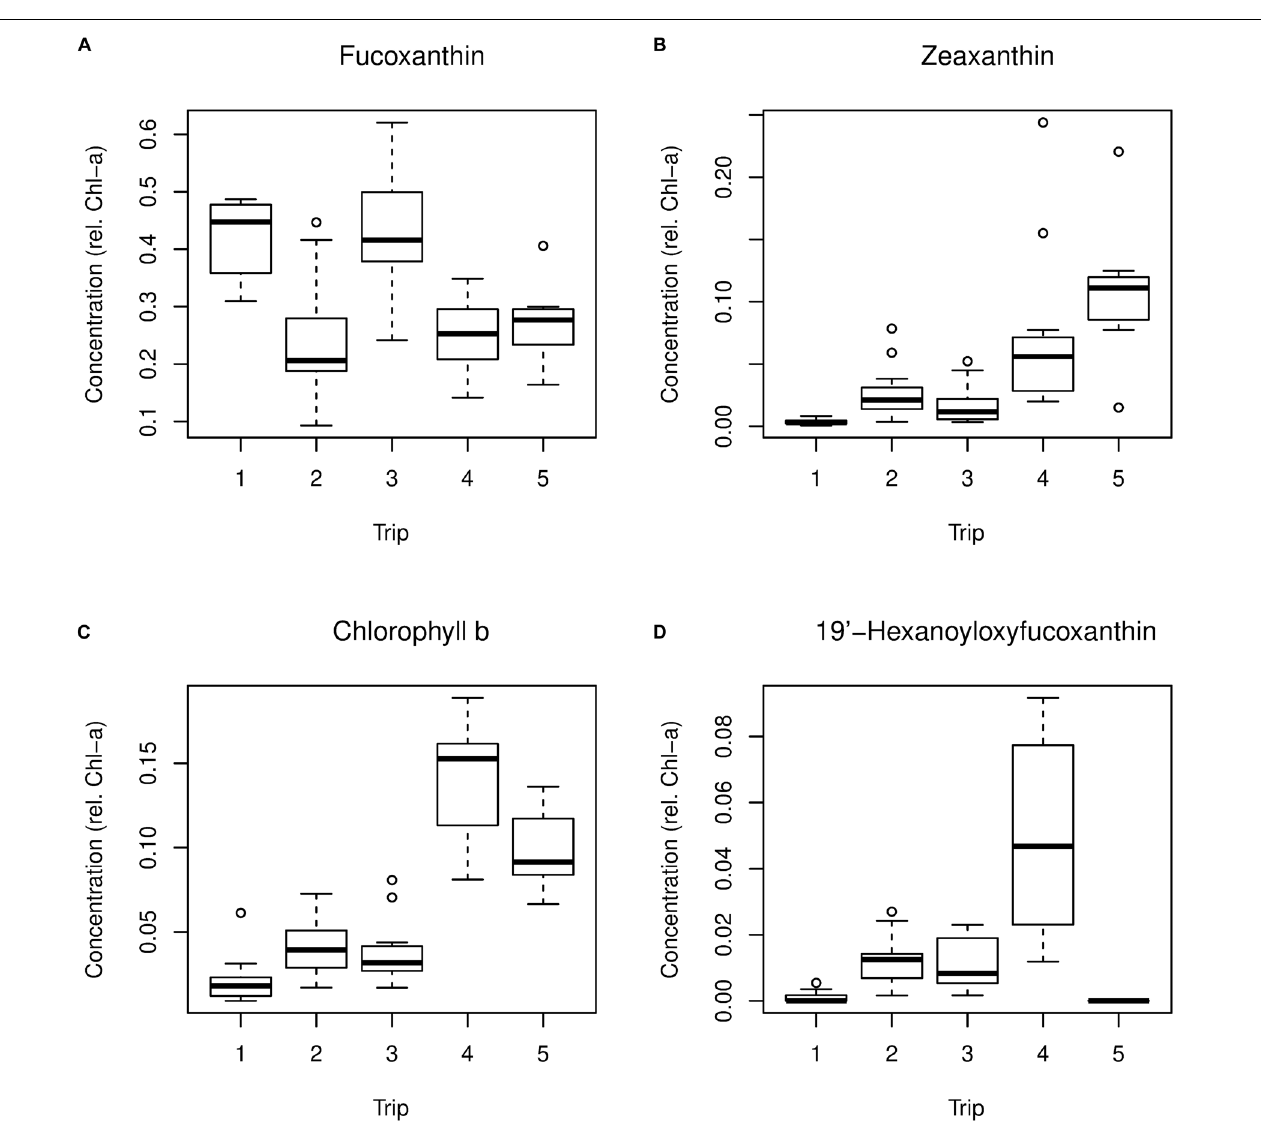
FIGURE 9 | Boxplots showing variation in selected pigments by trip; (A) Fucoxanthin , (B) Zeaxanthin , (C) Chlorophyll b and (D)